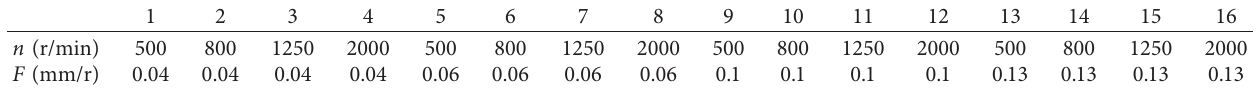
Table 3: The parameter of the orthogonal array.